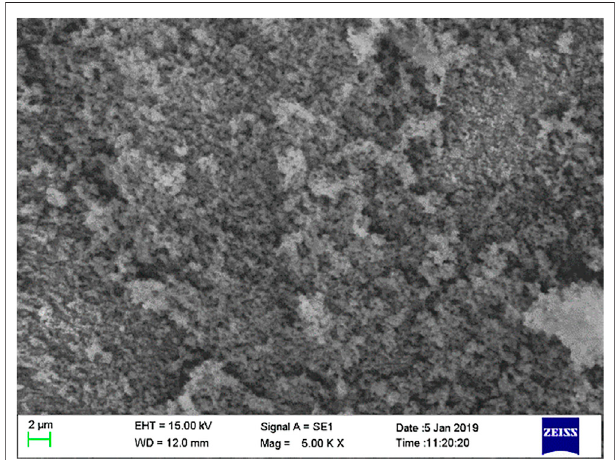
FIGURE 4 | SEM images of cement and SCMs, silica fume.